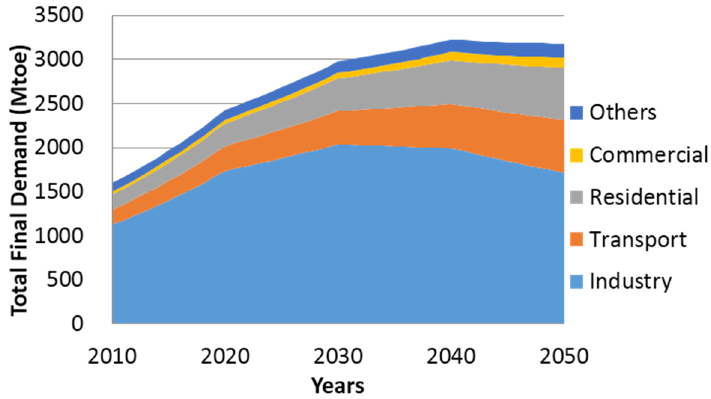
Figure 4. Total final demand of China by 2050 in the Reference